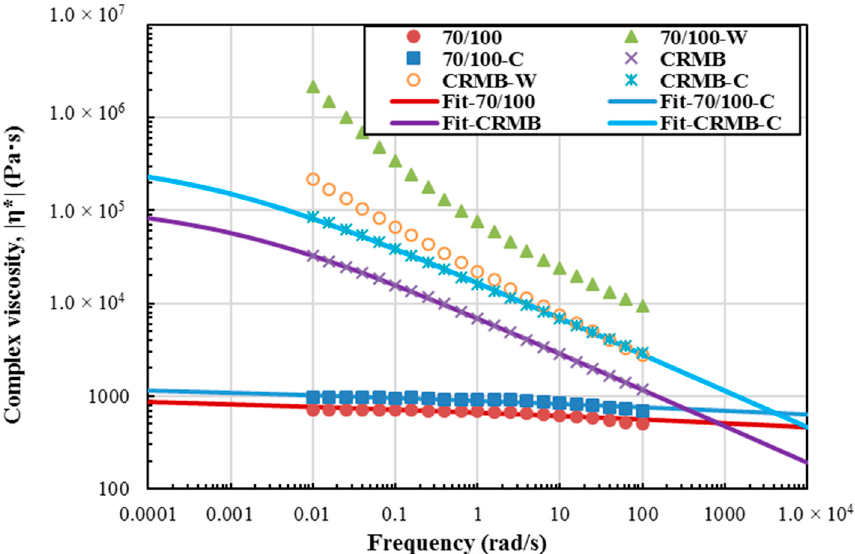
Figure 5. Measured and model predicted viscosity values for different binders at 50 °C. Table 4. Zero shear viscosity (ZSV) fitting results using the Cross model.